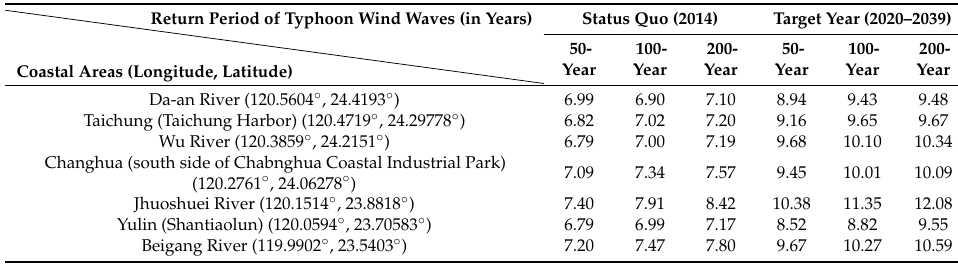
Table 2. Maximum typhoon-induced wave heights of different return periods for the target’s future. Latitude)Return Period of Typhoon Wind Waves (in Years) Coastal Areas (Longitude,